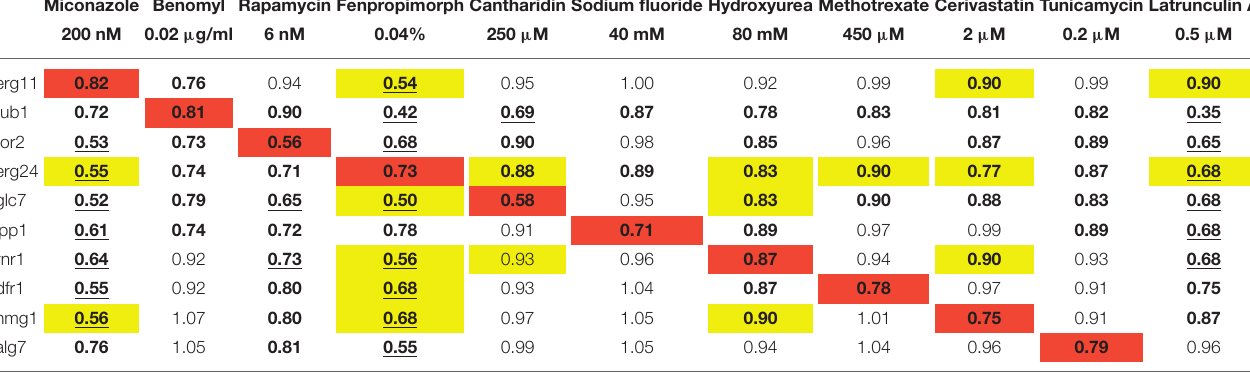
TABLE 2 | Hundred and ten fitness scores of heterozygous mutants in drugs. Miconazole Benomyl Rapamycin Fenpropimorph Cantharidin Sodium fluoride Hydroxyurea Methotrexate Cerivastatin Tunicamycin Latrunculin